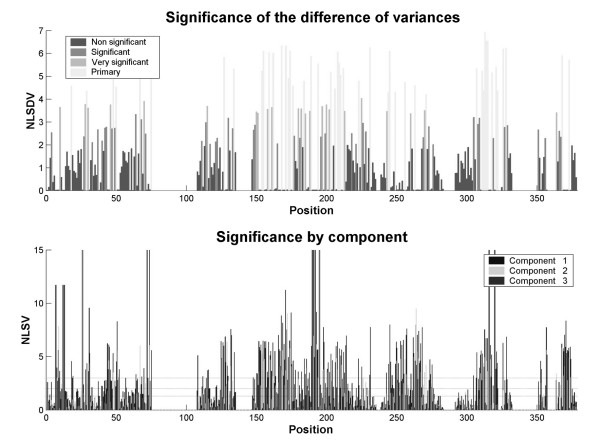
Result plots for the global significance of the positions (top) and the significances of variances in each component (bottom). NLSDV: negative of the base-10 logarithm of the significance of the difference of variances; NLSV: negative of the base-10 logarithm of the significance of variances.